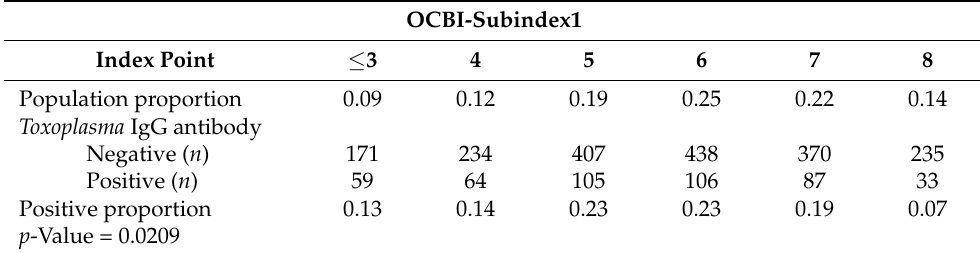
Table 8. Overall index of cardiovascular biomarkers